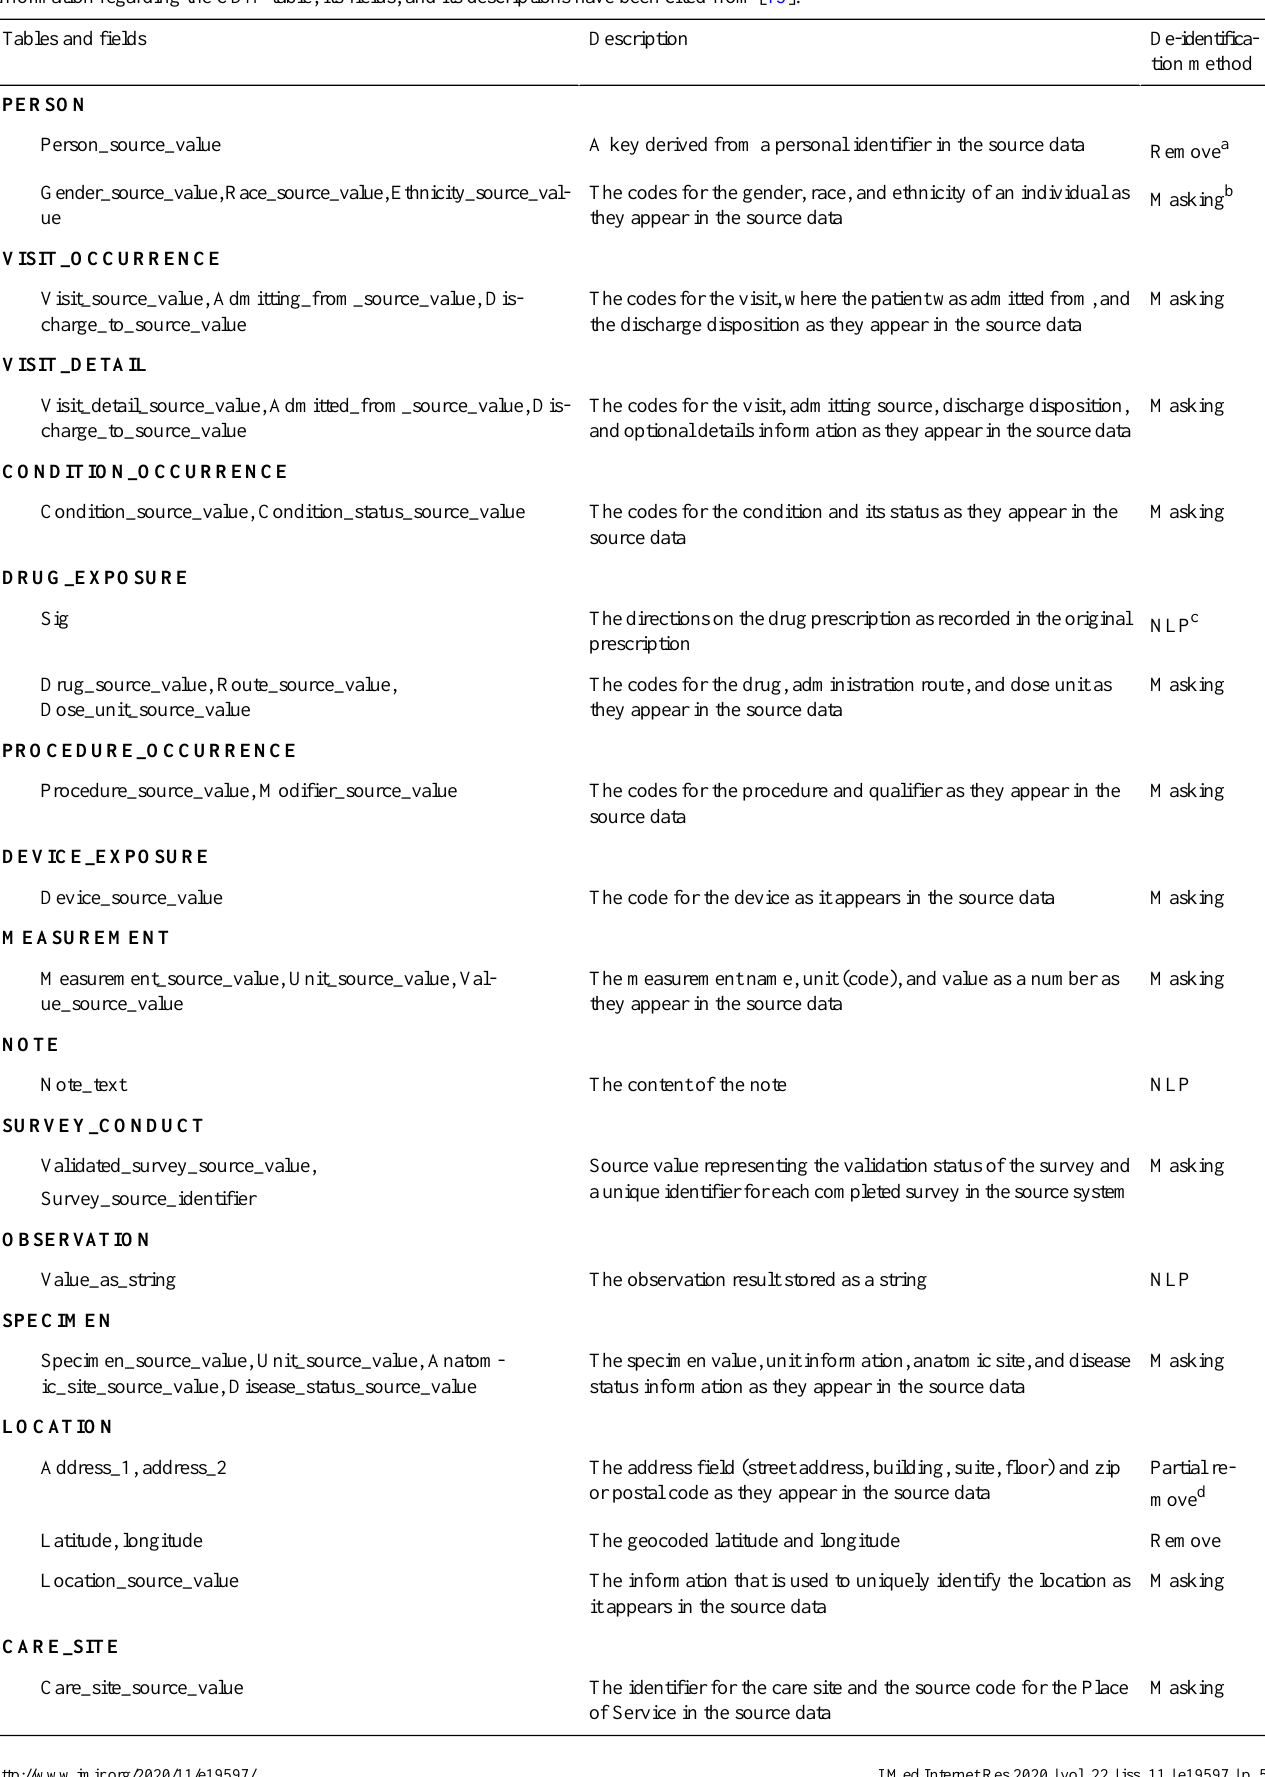
Table 1. Proposal for enhanced de-identification for the Observational Medical Outcomes Partnership Common Data Model (OMOP-CDM) specification. Information regarding the CDM table, its fields, and its descriptions have been cited from